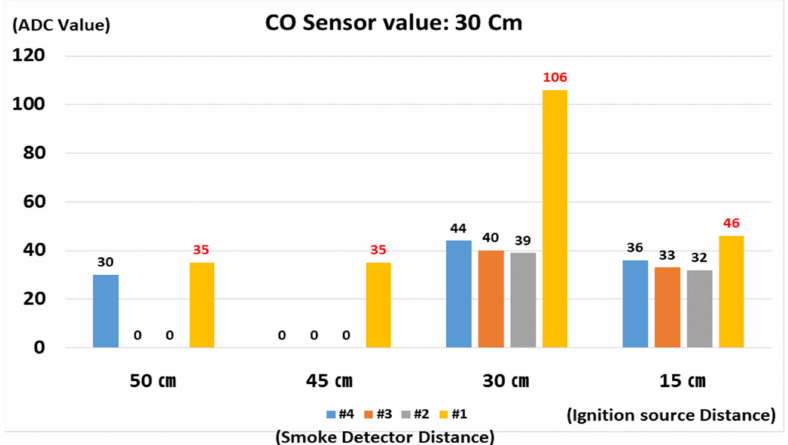
Figure 15. Carbon monoxide detection concentration for ignition source height of 30